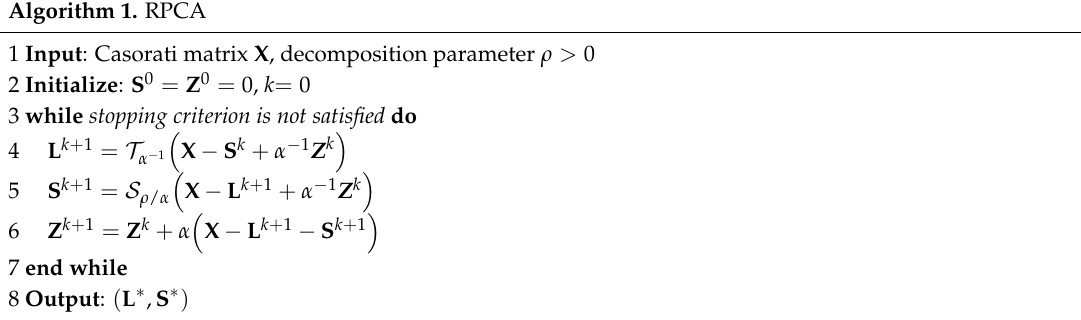
Algorithm 1. RPCA